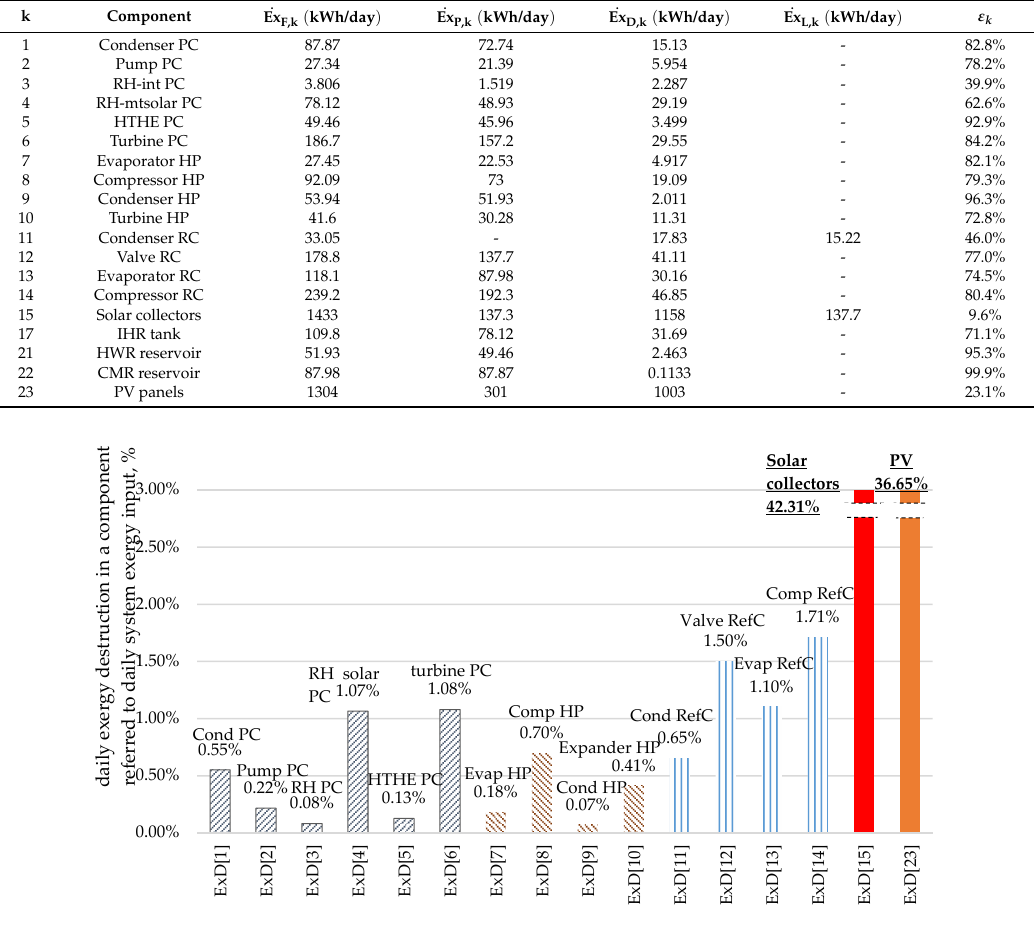
Figure 7. Relative daily exergy destruction and/or losses in all components of the TEES system (reference day of May in Crotone).